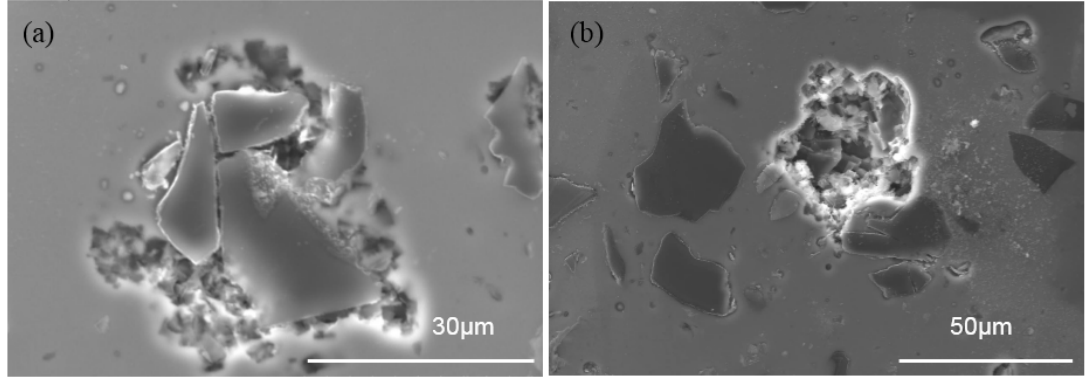
Figure 8. Galvanic current and galvanic potential measured between AA1100 and B 4 C wafer in 3.5 wt.% NaCl solution.